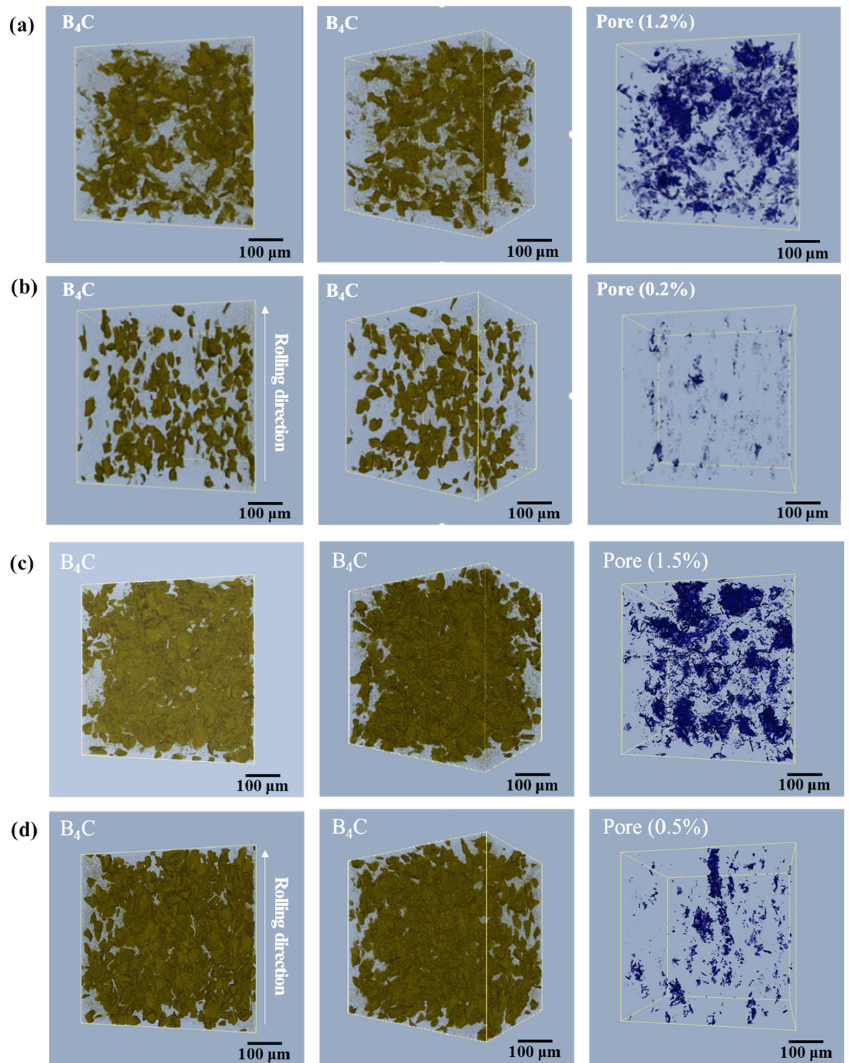
Figure 2. Three-dimensional microstructures of B 4 C/Al6061 stir-cast MMCs with ( a ) 5 vol.% and ( c ) 20 vol.% B 4 C and hot-rolled MMCs with ( b ) 5 vol.% and ( d ) 20 vol.% B 4 C. 20 vol.% B 4 C and hot-rolled MMCs with ( b ) 5 vol.% and ( d ) 20 vol.% B 4